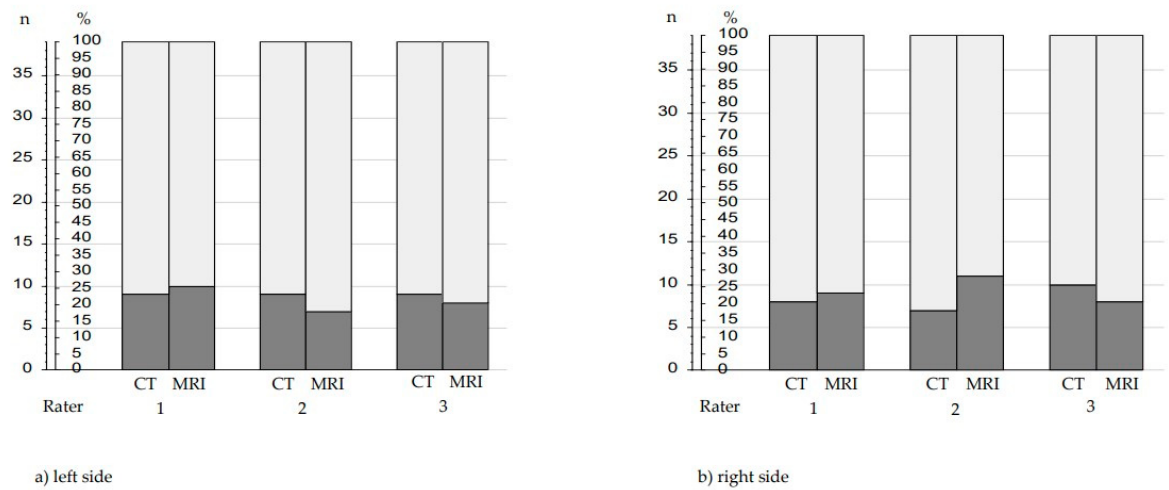
Figure 4. Electrode arrays (FLEX 28 vs. 31.5 mm electrode array) as suggested by the 3 raters based on CT vs. MRT data in ( a ) left or ( b ) right cochleae; light grey = number of 31.5 mm electrode arrays; dark grey = number of FLEX 28 electrode arrays.